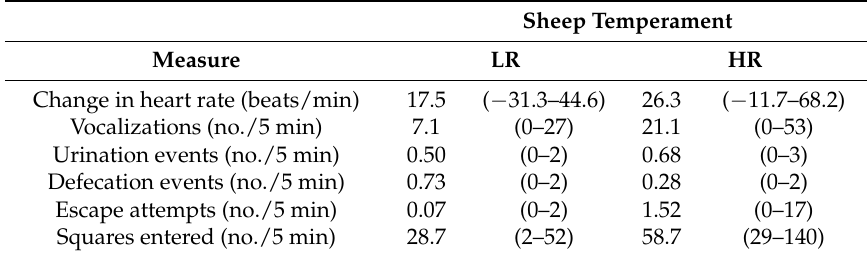
Table 2. Average and range of the heart rate and behavioral response of low (LR) and high (HR) reactive ewes during a five-minute open-field test.